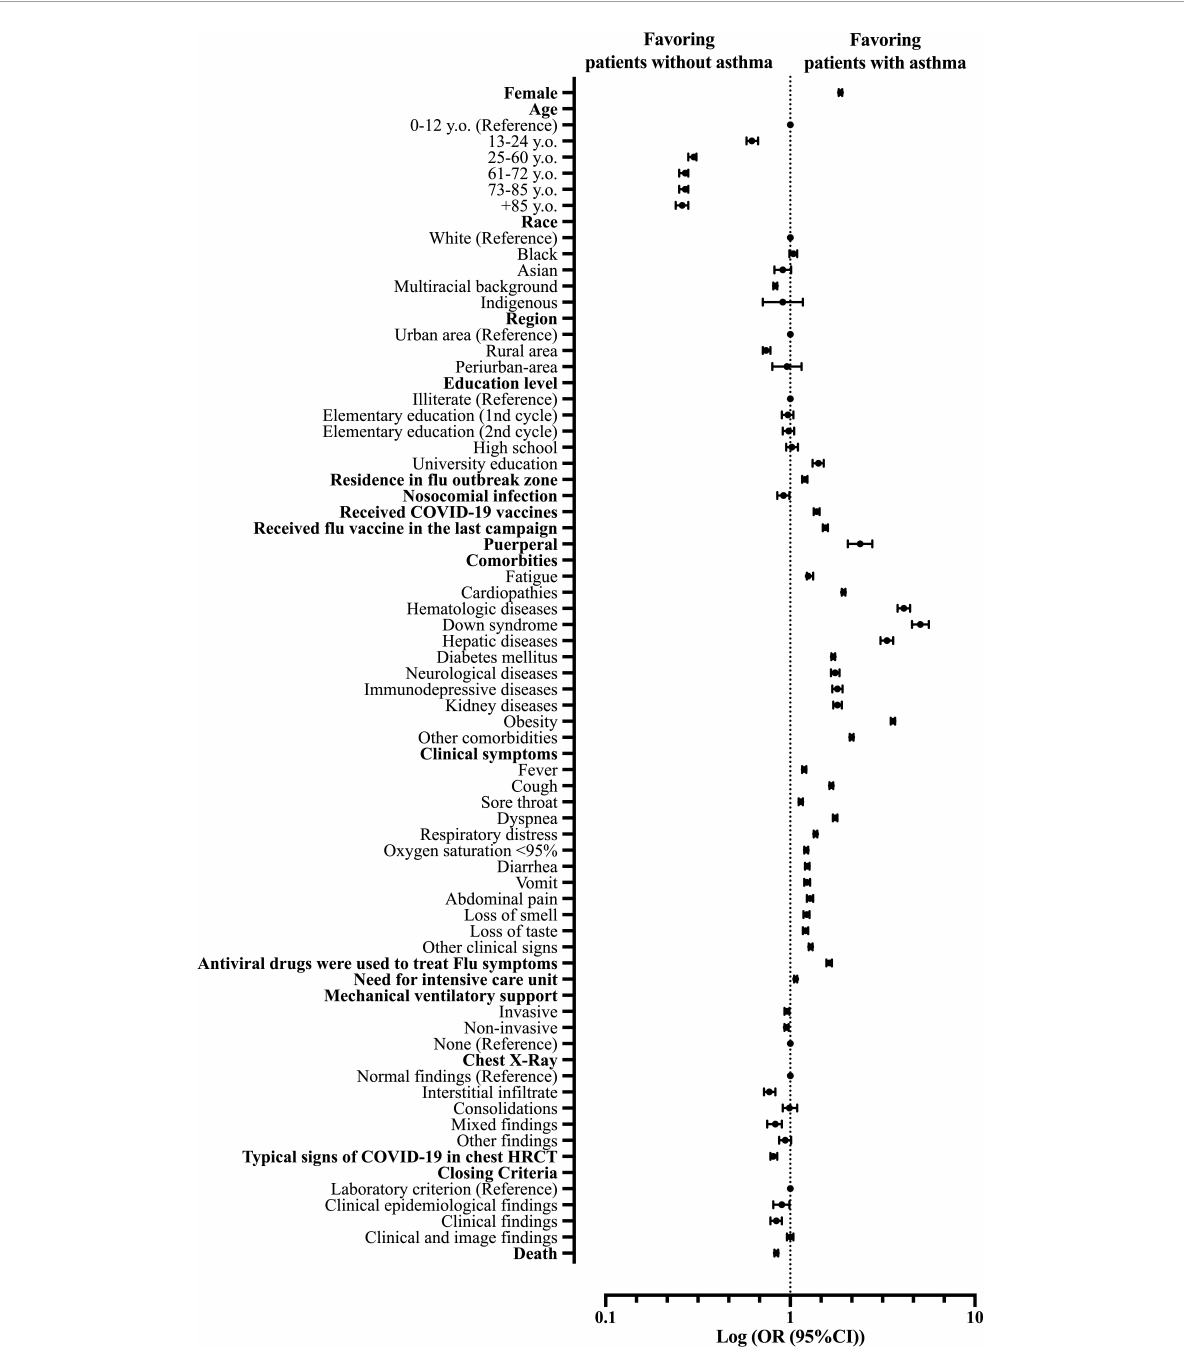
FIGURE3 Patients’ characteristics associated with the asthma phenotype in patients hospitalized with severe acute respiratory syndrome (SARS) due to coronavirus disease (COVID-19) in Brazil. OR, odds ratio; 95% CI, 95% confidence interval; HRCT, high-resolution computed tomography of the